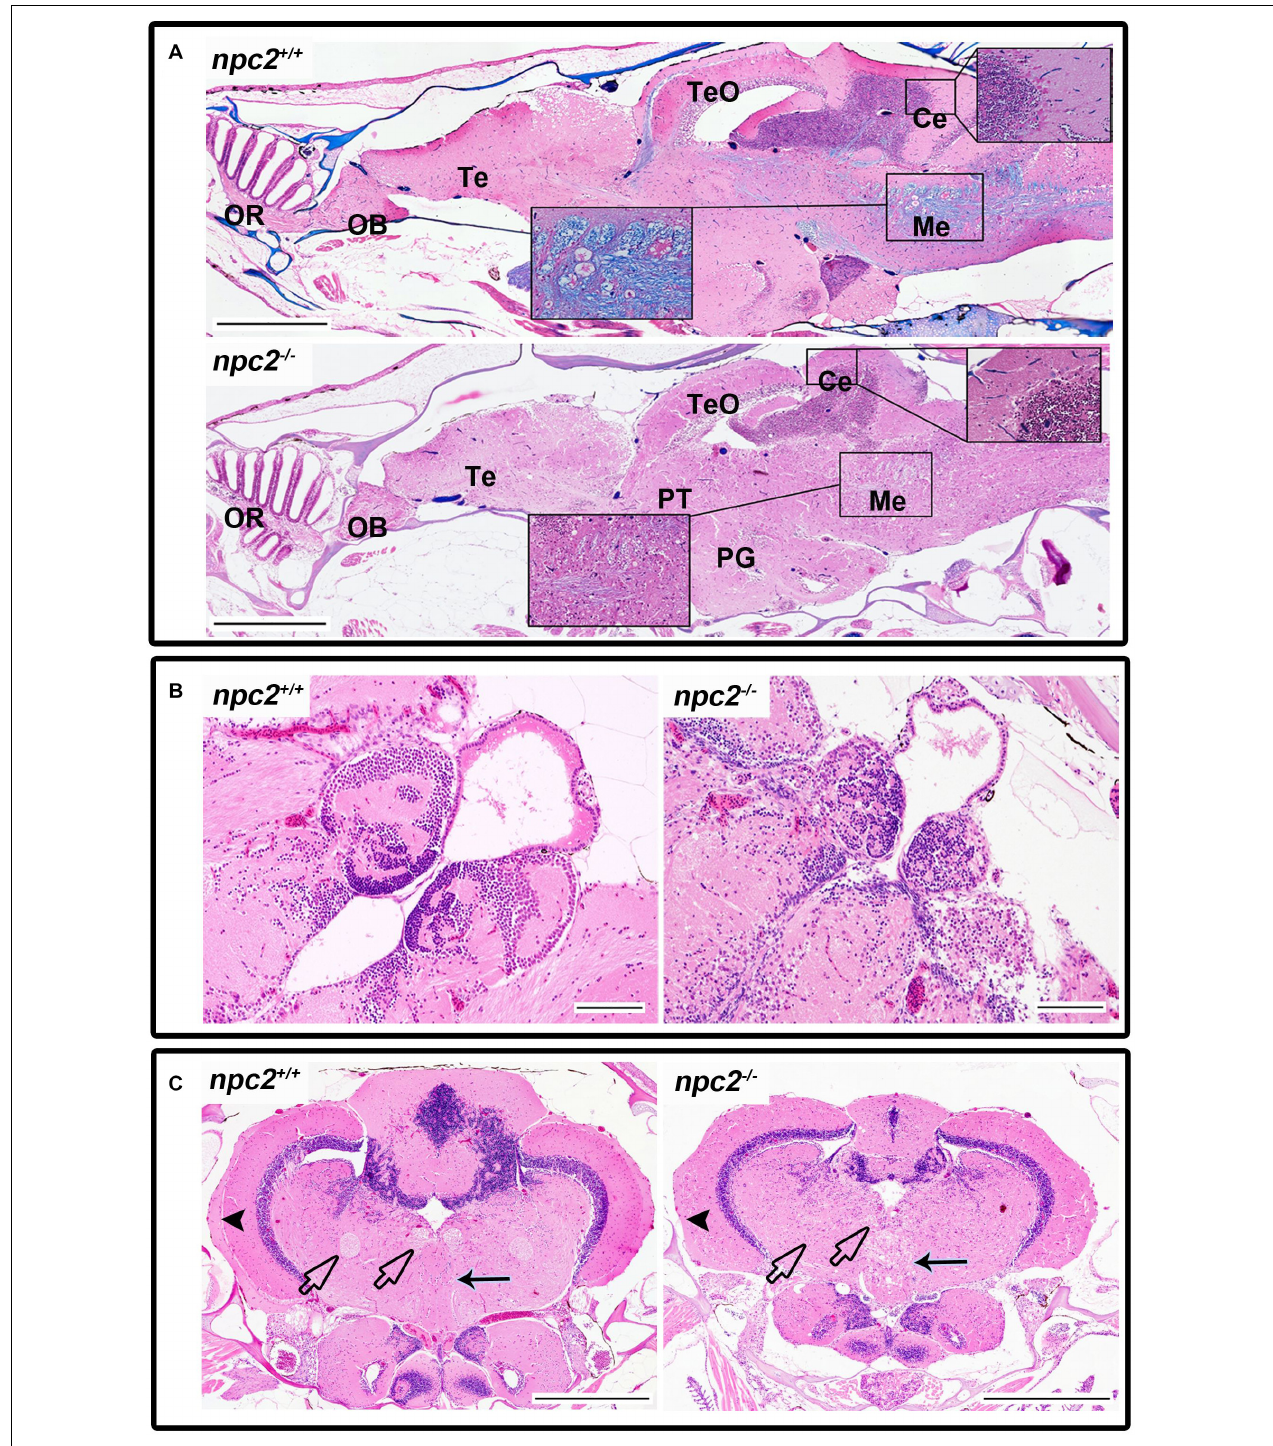
FIGURE 6 | Pathological changes in the central nervous system in adult npc2 − / − zebrafish. (A) Luxol fast blue staining showed differences in myelination between wildtype and npc2 − / − fish. (B) Changes in habenula structure were present in some npc2 − / − fish, which lacked the characteristic structure of this part of the habenular tract. (C) Midbrain with vacuolization of the habenula tract (blue arrow) with fascicular retroflexus (blue arrowhead) and degenerative changes in the medial and lateral longitudinal fascicle. OB, olfactory bulb; OR, olfactory rosette; Te, telencephalon; TeO, tectum opticum; Ce, cerebellum; Me, medulla; PG, preglomerular complex; and PT, posterior tuberculum. (A) LFB staining. Scale bar = 500 µ m. (B,C) H&E staining. Scale bar = 100 µ m. (C) scale bar = 500 µ m.